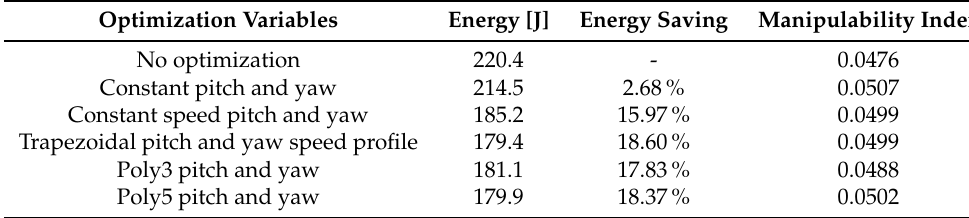
Table 5. Energy minimization: test-case I, motion along a horizontal line.